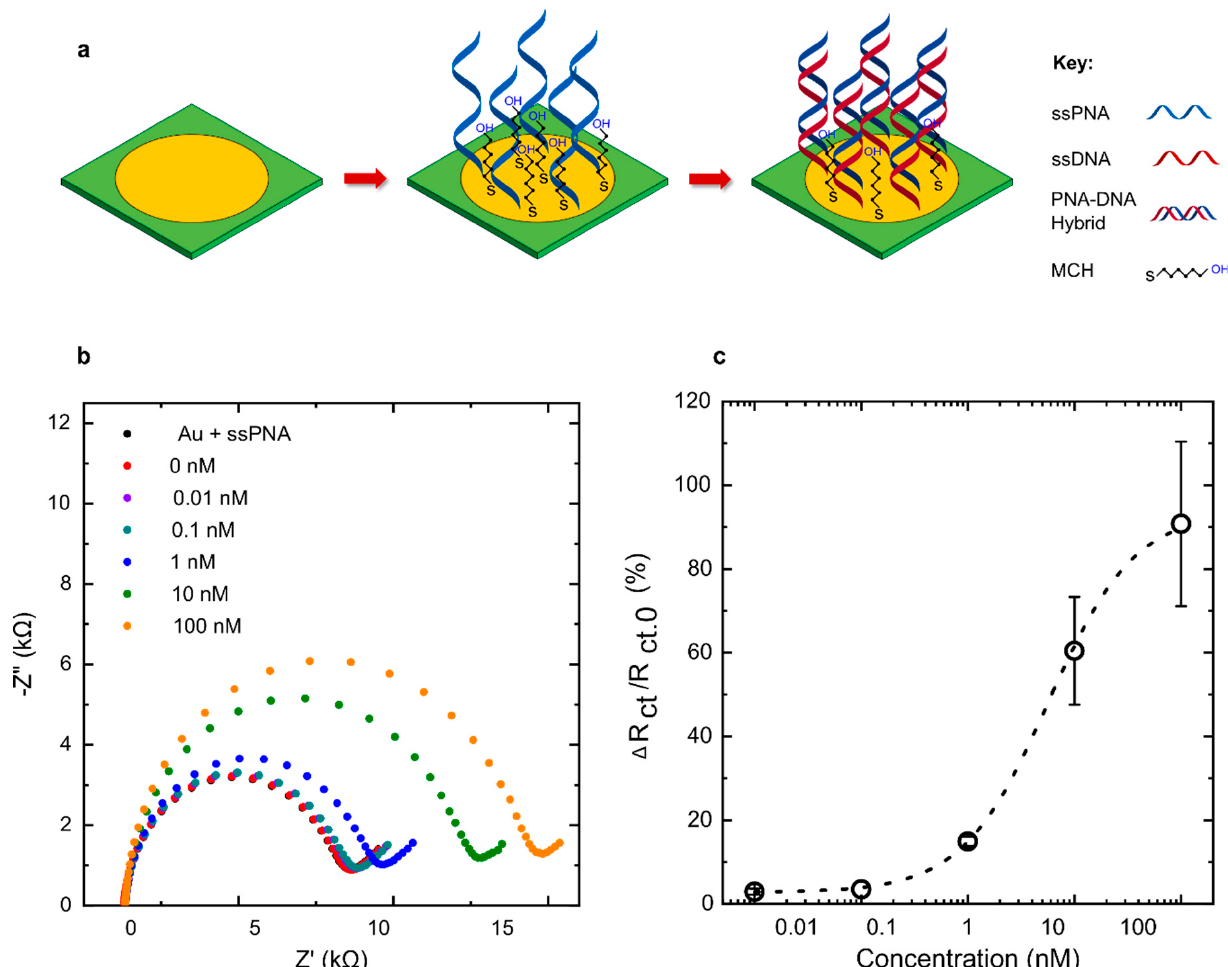
Figure 6. EIS-based PNA–DNA hybridisation assay on commercial PCB electrodes. ( a ) PCB gold electrode functionalised first with thiolated PNA probes and co-immobilised with MCH spacer molecules before direct hybridisation with ssDNA samples. ( b ) Typical Nyquist plots obtained for PNA–DNA hybridisation using thiol surface chemistry on PCB with five concentrations of target ssDNA and blank sample. ( c ) A calibration curve for the percentage change in R ct using five concentrations of ssDNA in buffer ( N = 3).